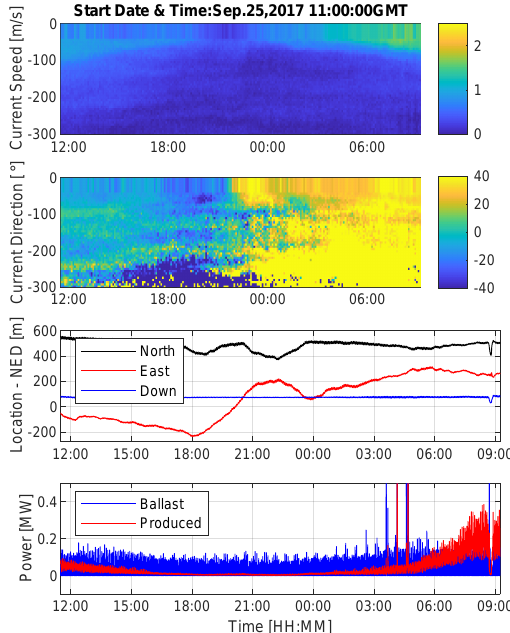
Fig. 8. Normal condition (October 1, 2017): time histories of the OCT’s states, i.e., Euler angle, location-NED, and power.